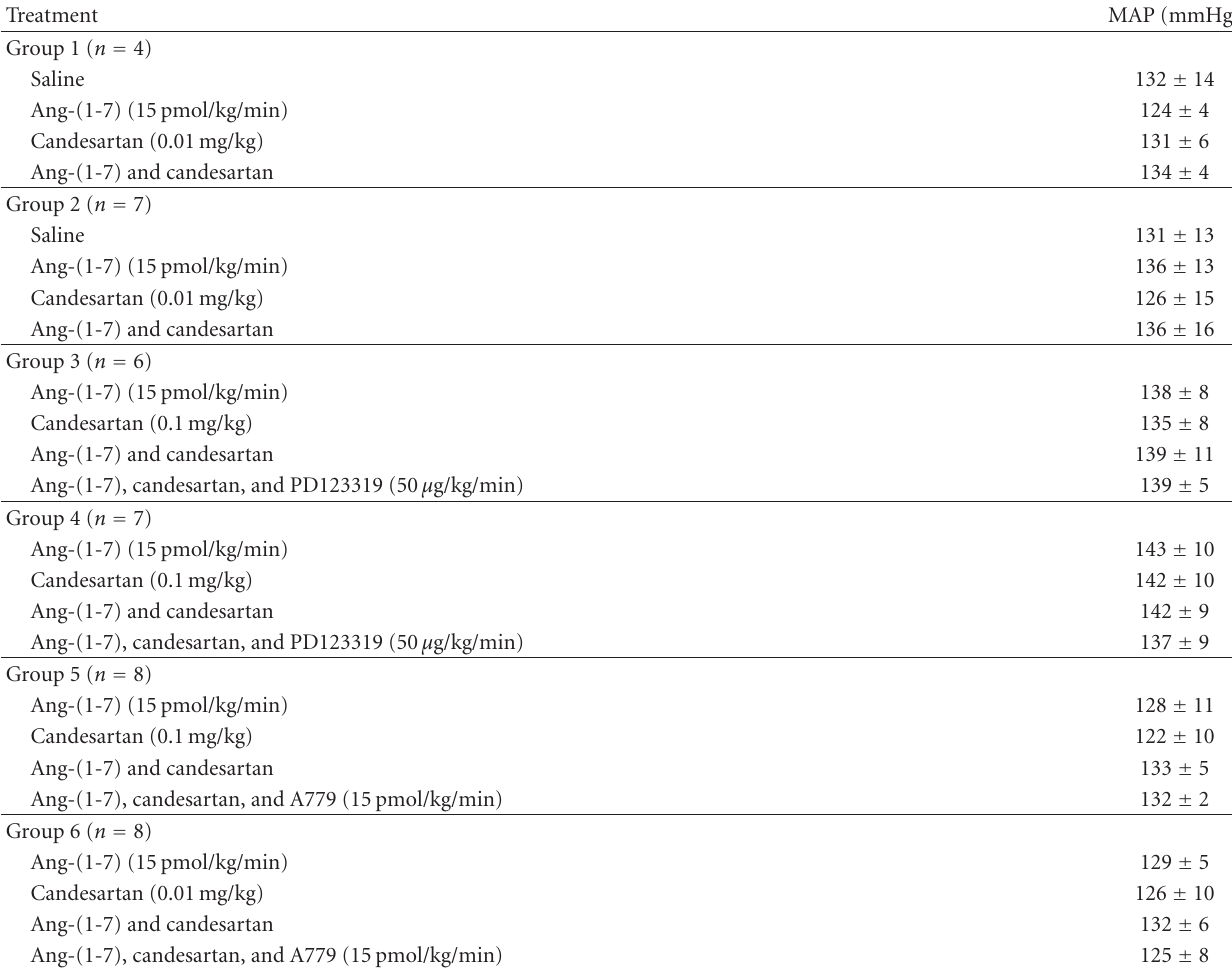
Table 1: Resting MAP recorded on separate days before drug treatments, as